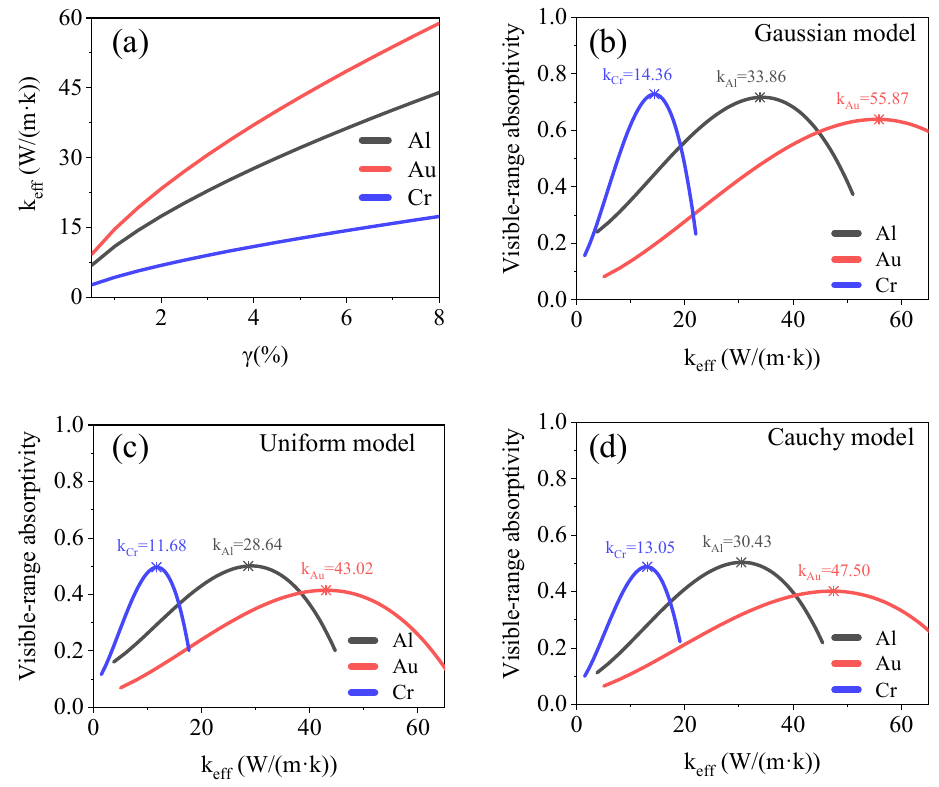
Figure 8. ( a ) Relationship between filling factor and equivalent thermal conductivity of model used. ( b – d ) Relationship between equivalent thermal conductivity and visible-range absorptivity for Gaussian, uniform, and Cauchy models. Equivalent thermal conductivity of model with maximum absorptivity is marked in the figures.